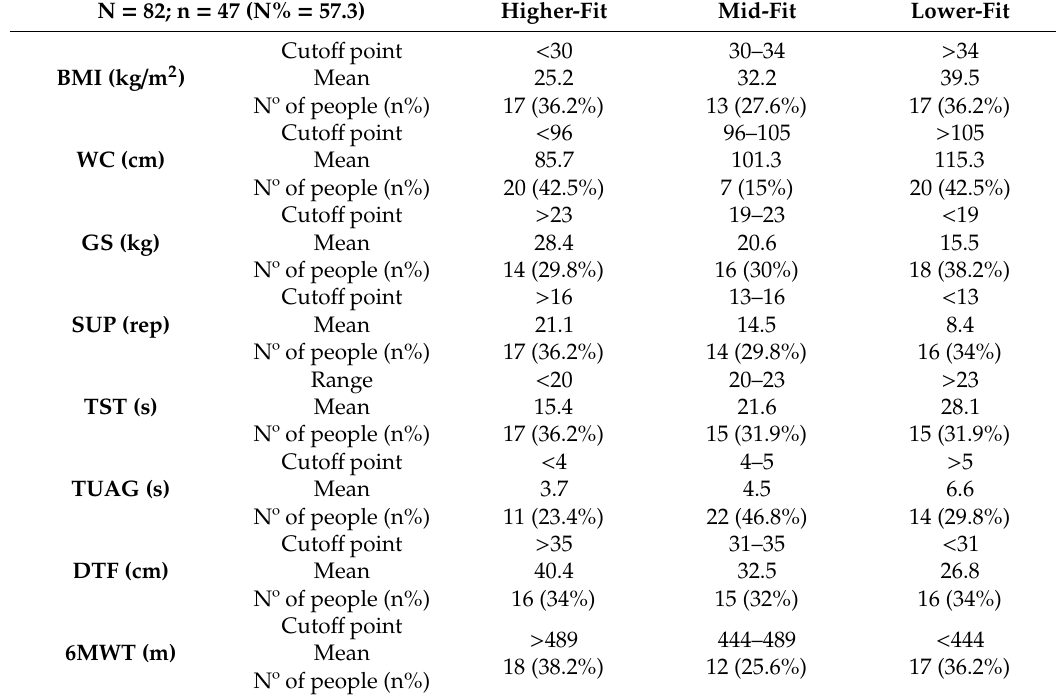
Table 5. Middle-aged women (30–50 years old) results for each variable categorized in 3 PF levels. N = 82; n = 47 (N% = 57.3)